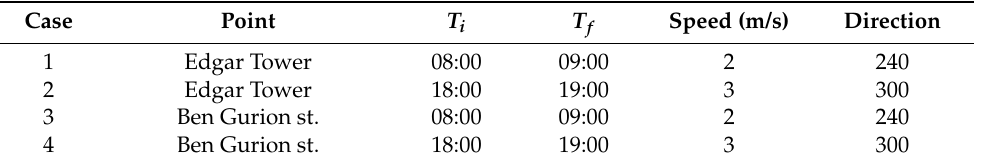
Table 2. The wind parameters of the the four cases analyzed in this work. Case Point T i T f Speed (m/s) Direction Edgar